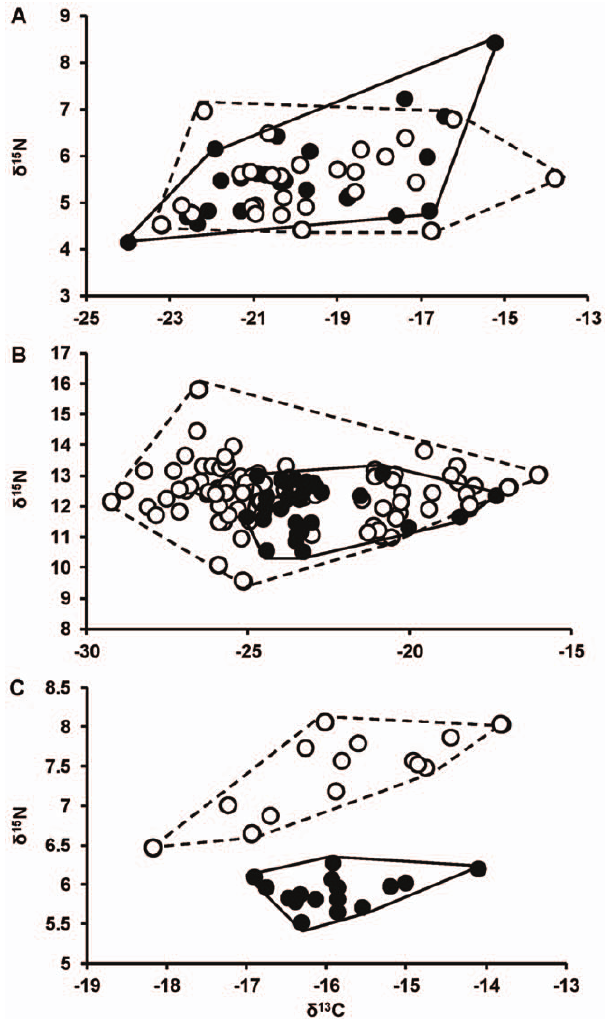
Figure 3. Isotopic niche use of two ontogenetically distinct groups. Differences in niche width (for illustration purposes repre- sented by convex hull polygons) of a small (solid line) and large (dashed line) size class of A) Eupemphix nattereri, B) Lutjanus griseus, and C) Atherinomorus stipes represented in a d 13 C- d 15 N niche space. Closed circles represent isotope data of individual juveniles and open circles individual adults (or sub-adults in case of L. griseus ).